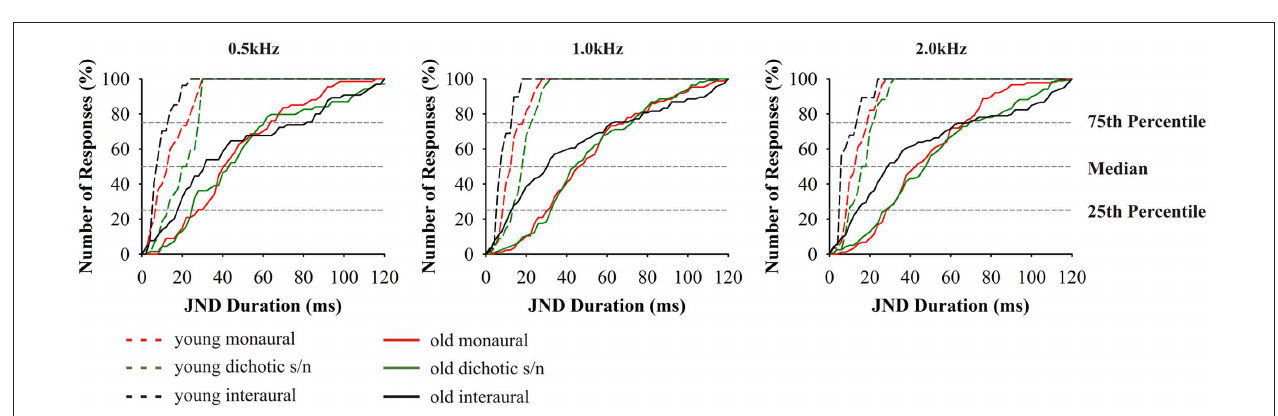
line types: 20–29 ( n = 16) dashed lines, 65–89 ( n = 59) solid. Data from 20- to 29-year-old subjects taken from Bungert-Kahl et al. (2004). Poorest performance was achieved in interaural tasks which showed the highest intersubject variability.